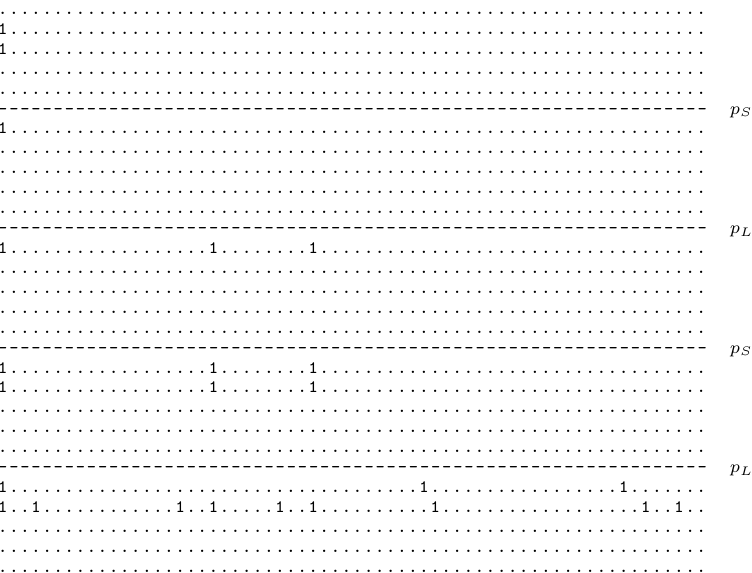
Figure 1: 3-round trail with 15 [1, 3, 11] active Sboxes and weight 40 [2, 6, 32].